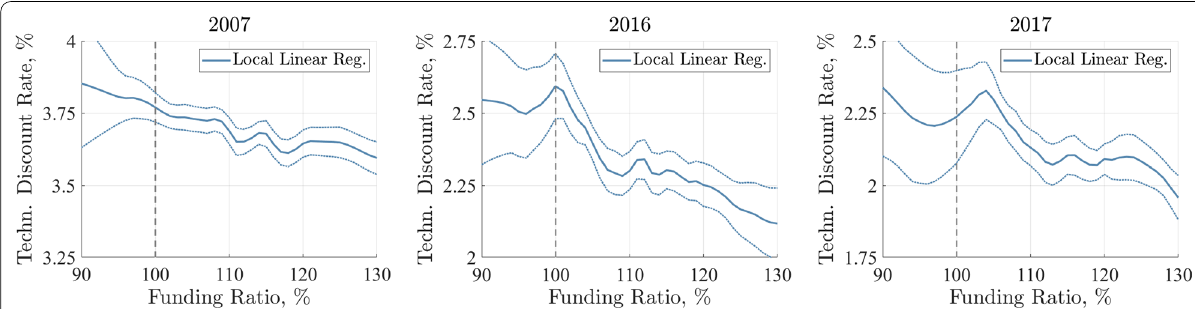
Fig. 4 Average Technical Discount Rate—Local Linear Regression Figures show the weighted average discount rate (y-axis) used to discount pension liabilities of insurants, conditional on the funding ratio of the funds (x-axis). Blue solid lines are averages estimated by a local linear regression using a tricube kernel with varying bandwidths, considering the closest 20% of observations. Dotted blue lines show the 95% confidence band from bootstrapped standard errors (500 iterations). The average discount interest rate decreases the better a fund’s funding ratio. The sample includes only private and public funds without state guarantees, and only includes funds with a funding ratio between 81.5 and 152.3% (0.5th–95th percentile